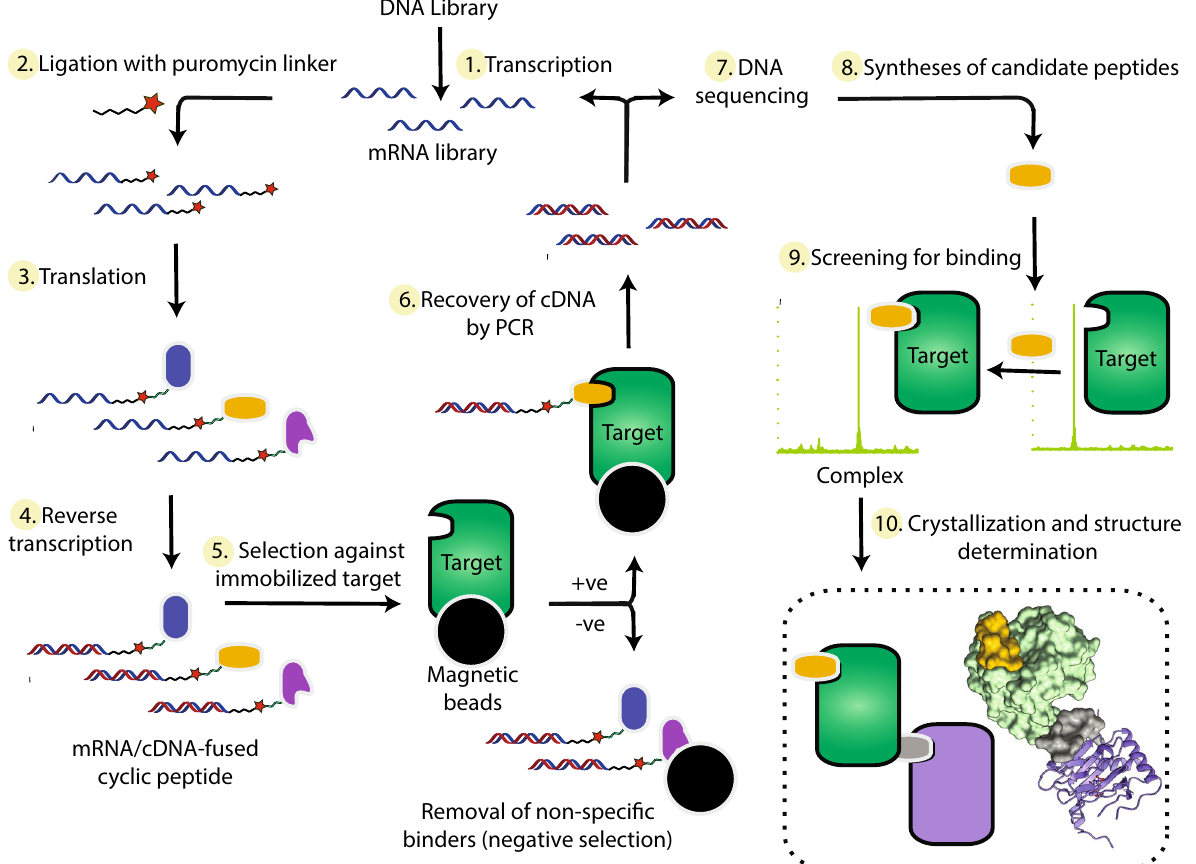
Figure 6. Overview of the RaPID selection procedure coupled to protein structure determination. See references 8,9 for more details. The starting DNA library is transcribed into an mRNA pool which is ligated with puromycin-derivatized oligonucleotides, then used as templates for in vitro translation. This translation reaction mixture contains 19 proteinogenic amino acids (excepting methionine) and is supplemented with an initiator tRNA acylated with chloroacetyl-d-tyrosine. The peptide is cyclised by intramolecular S N 2 reaction between the chloroacetyl group and a C -terminal cysteine. The puromycin covalently links the coding mRNA strand to the corresponding translated CPs, so reverse transcription generates mRNA/cDNA-fused CPs. The mixture is incubated with magnetic beads to select for CPs binding to the immobilized target, then washed, before the cDNA associated with bound CPs is PCR amplified and sequenced. The peptides thus identified are synthesized by standard solid-phase synthesis, incubated with the target protein, and tested by MS-based screening (or other binding assay) for complex formation (kinetic assays may also be performed). Co-crystallization experiments involve mixing CPs and target protein typically at a 1–1.1:1 molar ratio, respectively. Alternatively, the complex can be purified by size exclusion chromatography. RaPID screens could also be performed on enzyme–substrate/-inhibitor complexes to promote identification of non-competitive CPs (NCCPs). Owing to their typically high stability, CPs are well-tolerated for screening a broad range of crystallization conditions with extremes of pH, temperature, ionic strength, ligands/additives, and precipitants. Thus, crystallization conditions screened are limited by the stability of the target protein, not that of the CP crystallization agent, which is often an issue with antibodies/‘crystallization chaperones’ 5